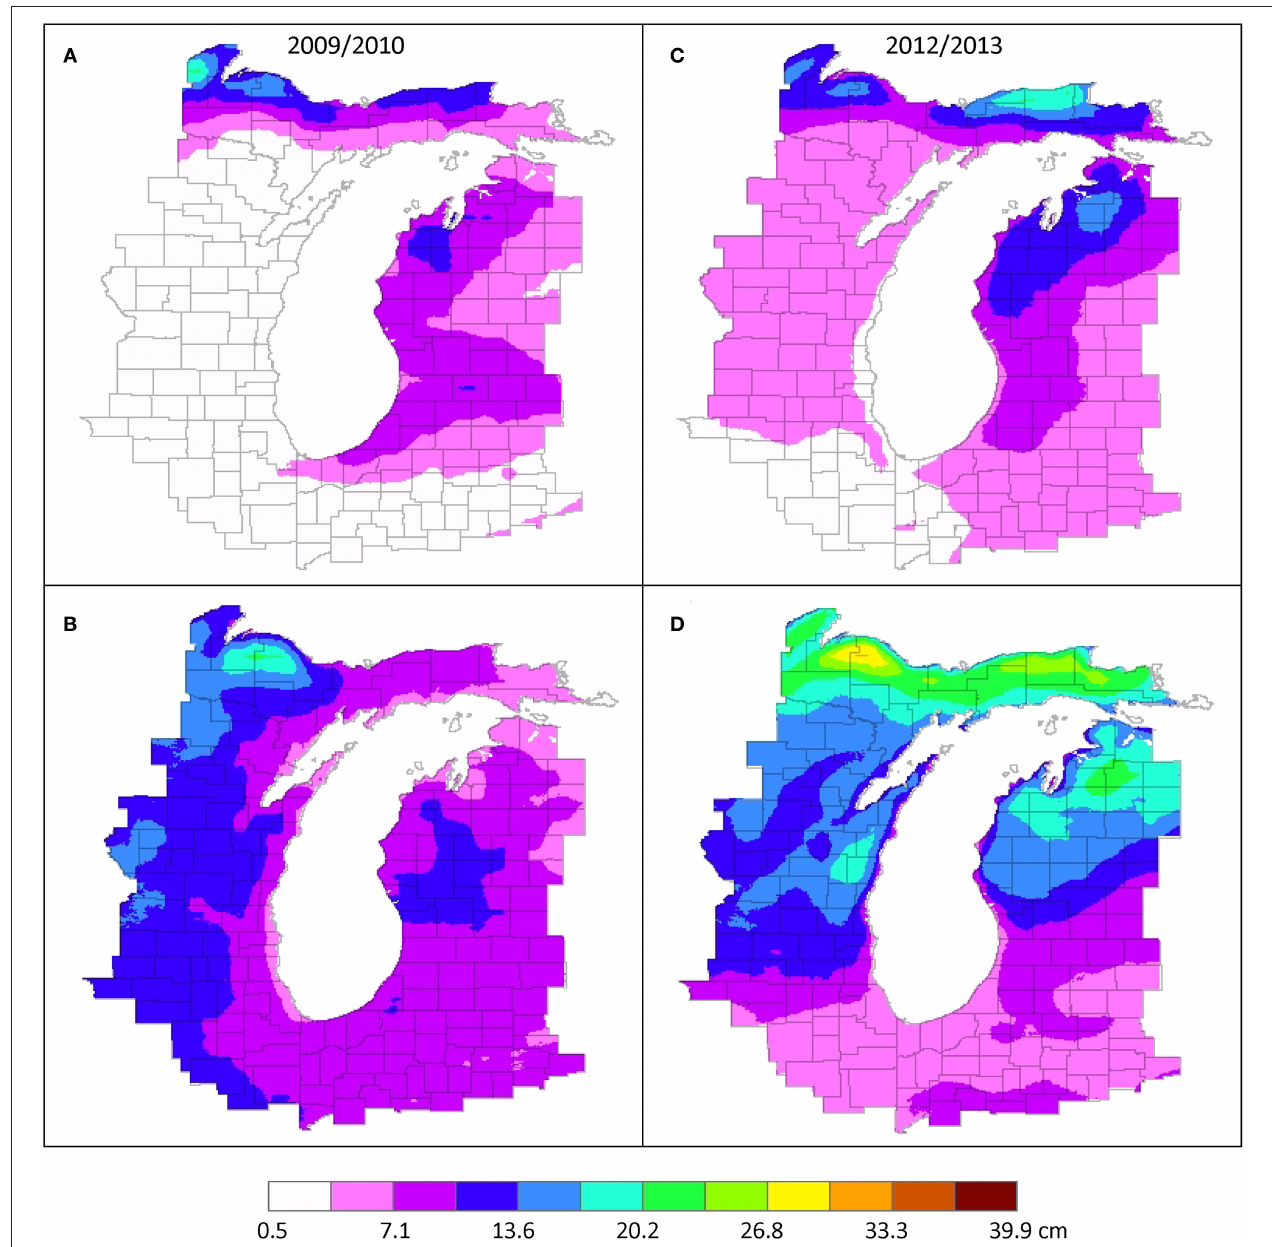
FIGURE 4 | The 2009/2010 cold-season LWE snowfall (cm) for (A) LES days and (B) non-LES days and the 2012/2013 cold-season LWE snowfall for (C) LES days and (D) non-LES days in the vicinity of Lake Michigan.